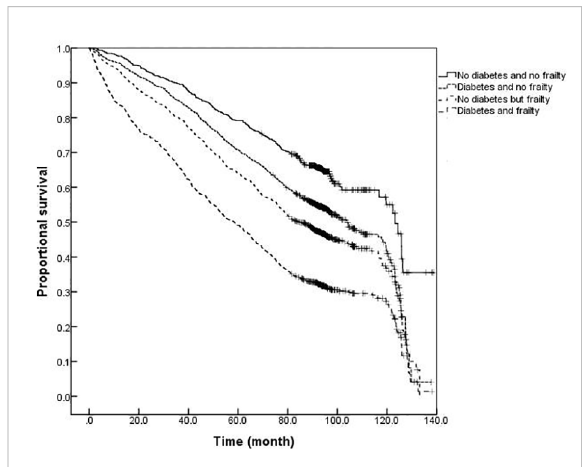
FIGURE 5 Kaplan-Meier curves for the proportional survival of older adults aged 70- years with different diabetes and frailty status.